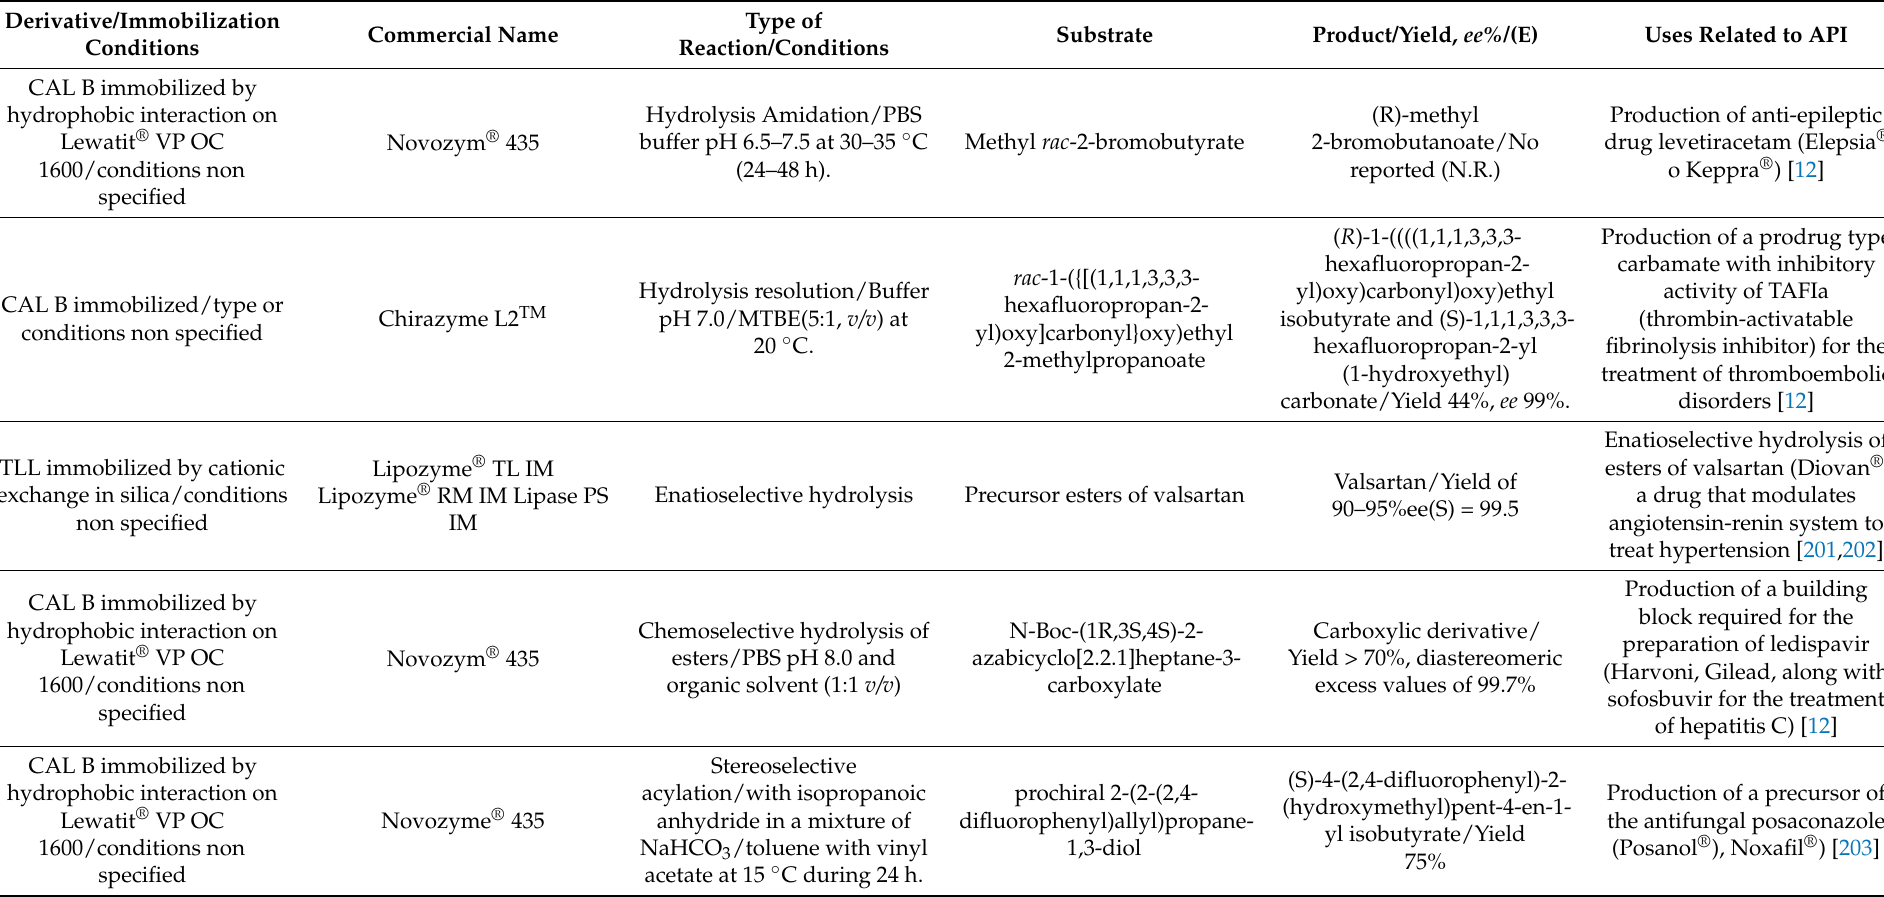
Table 4. Immobilized lipases to obtain APIs